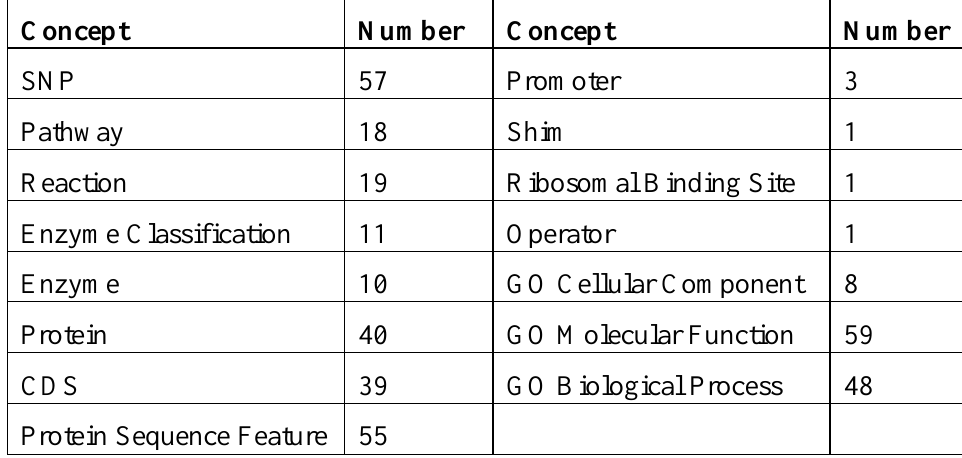
Table 3: Concepts associated with the high-probability